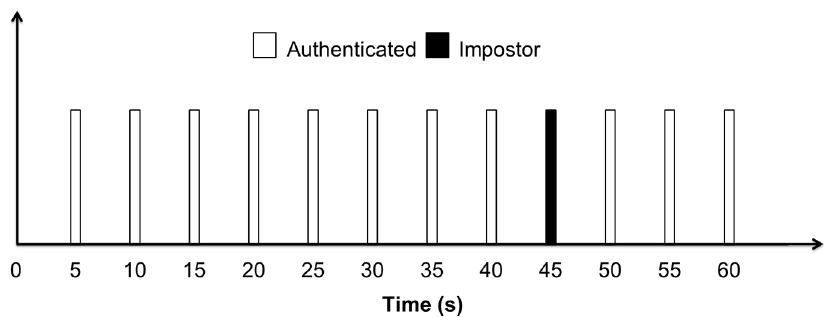
Figure 7. Euclidean distance between the authenticated user class feature vector and the feature vectors computed from testing data for different candidate users.